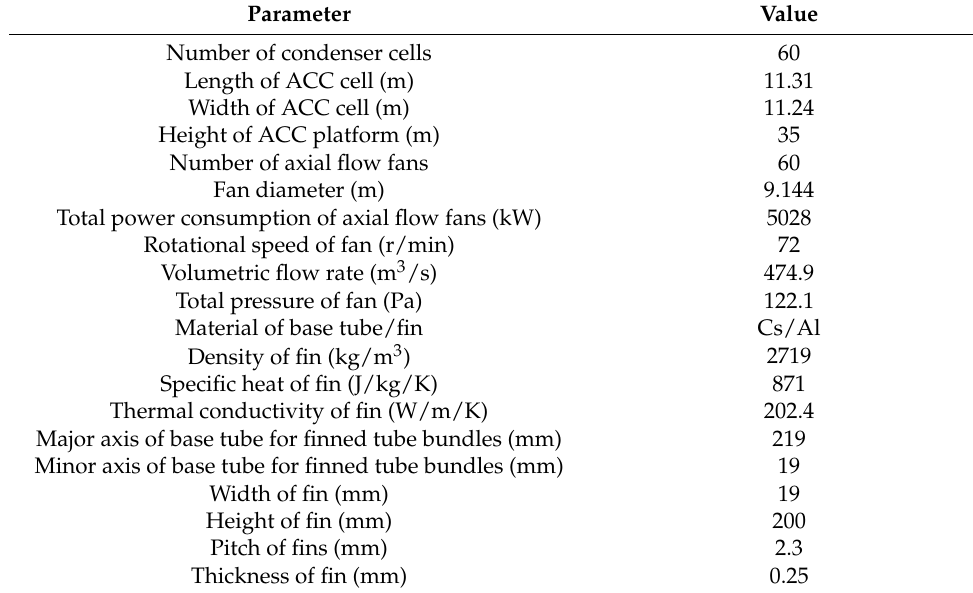
Figure 1. Layout of 2 × 300 MW direct dry cooling power generation unit: ( a ) main buildings, ACCs, and finned tube bundles; ( b ) ACC cell; ( c ) serial numbers of condenser cells. Table 1. Geometric parameters of ACCs.